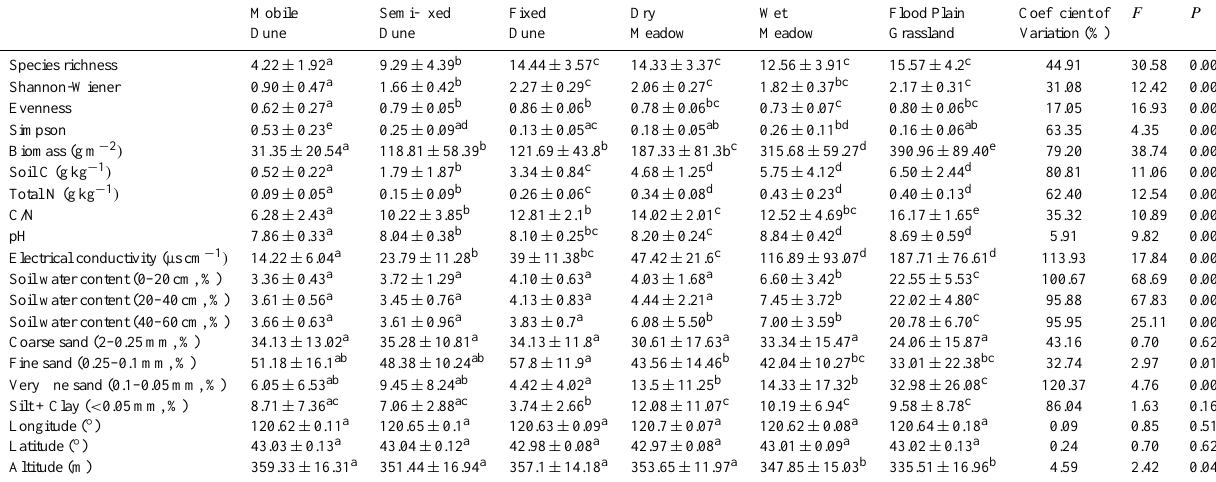
Table 1. Descriptive statistics of diversity parameters, productivity, soil variables and site characteristics (mean ± SD). Mobile Semi-fixed Fixed Dry Wet Flood Plain Coefficient of F P Dune Dune Dune Meadow Meadow Grassland Variation (%) Species